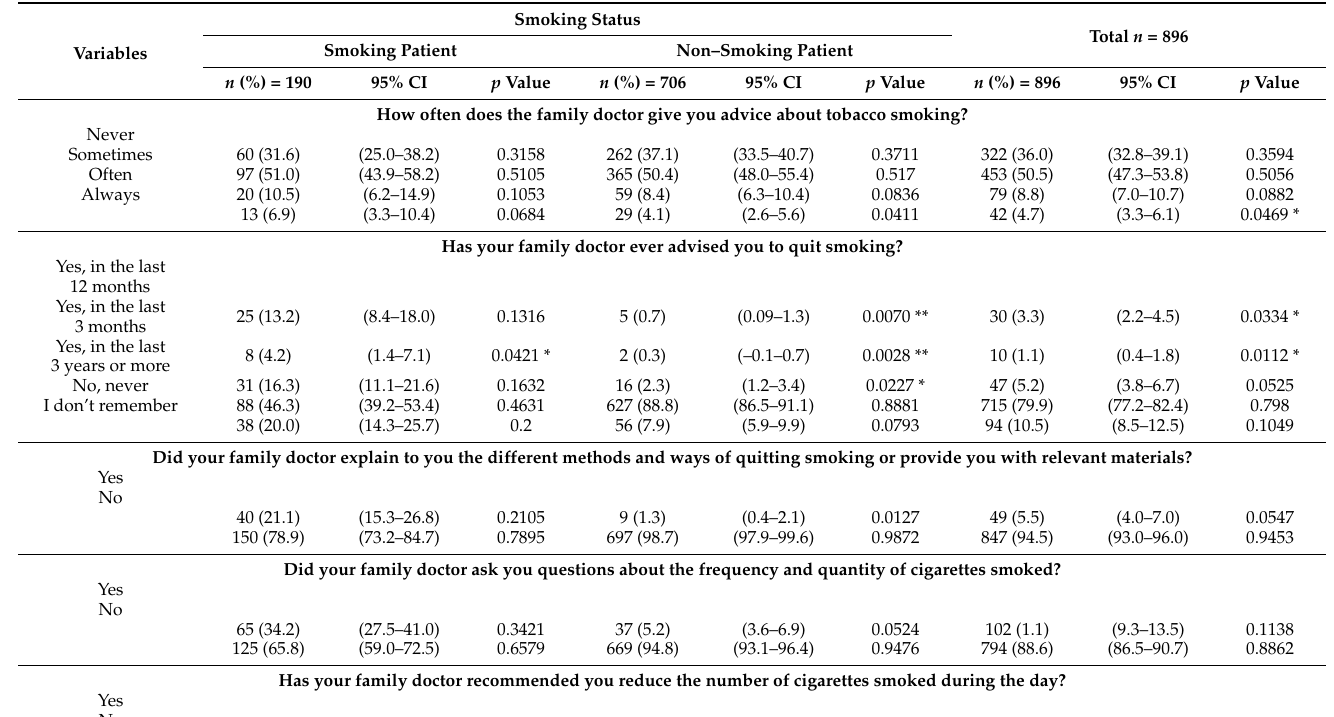
Table 3. Anti-tobacco counseling provided by a family doctor to smoking and non-smoking